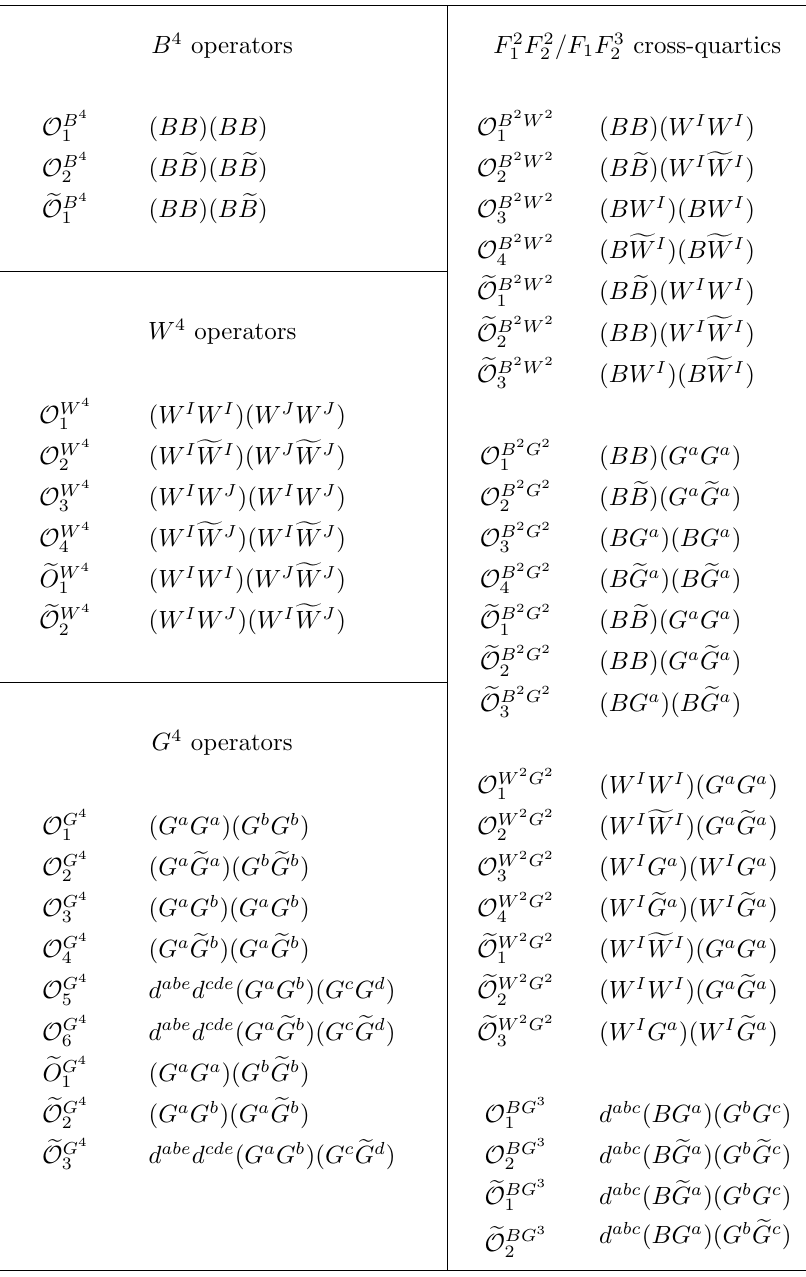
Table 1 . Basis of independent dimension-eight operators in the SMEFT that are quartic in gauge (cid:12)eld strengths. CP-violating operators are denoted with a tilde. Throughout the table, we have